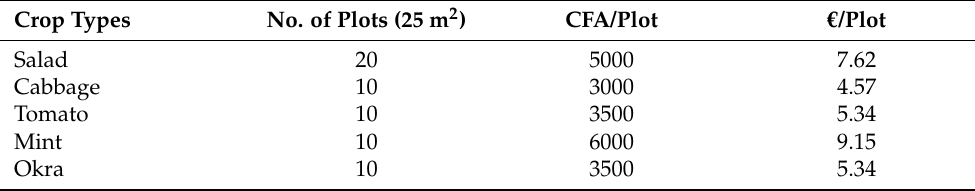
Figure 5. Farm profit for a reference farmer in a year (from 0.15 ha land). Figure 6. B/C ratio for a reference farmer in a year (from 0.15 ha land). The economic indicator results are in line with the traditional farming practice in the village, i.e., farming is simply a subsistence agricultural economy. It is almost a net ‐ zero profit activity but is a lifeline for survival. In case 2, the results show that the gross margin and farm profit are both negative. The B/C ratio is less than one. All three indicators suggest that such a diesel pump ‐ based irrigation system for the reference farm is not economically viable. One of the main rea ‐ sons is the high cost of diesel. Besides the economic indicators, additional environmental impacts of diesel use for irrigation are calculated in terms of CO 2 emissions per year (for 0.15 ha). To irrigate 0.15 ha of land in a year, about 2700 m 3 of water is considered for